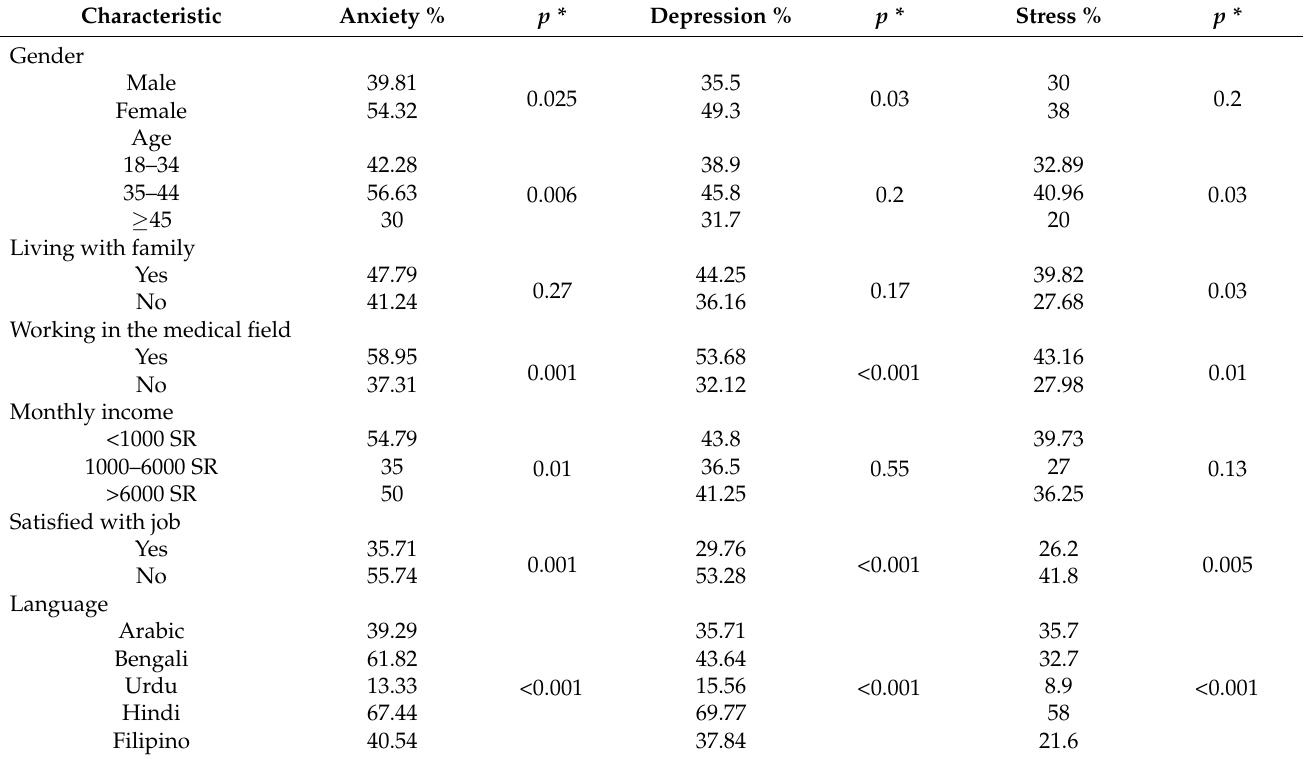
Table 2. Bivariate analysis of sociodemographic factors and psychological